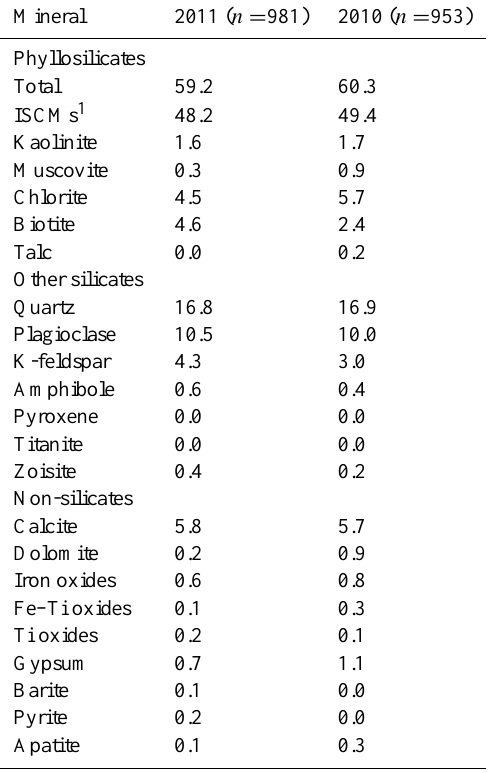
Table 4. Mineral number compositions of Asian dust TSPs col- lected on 1 May 2011 and 20 March 2010